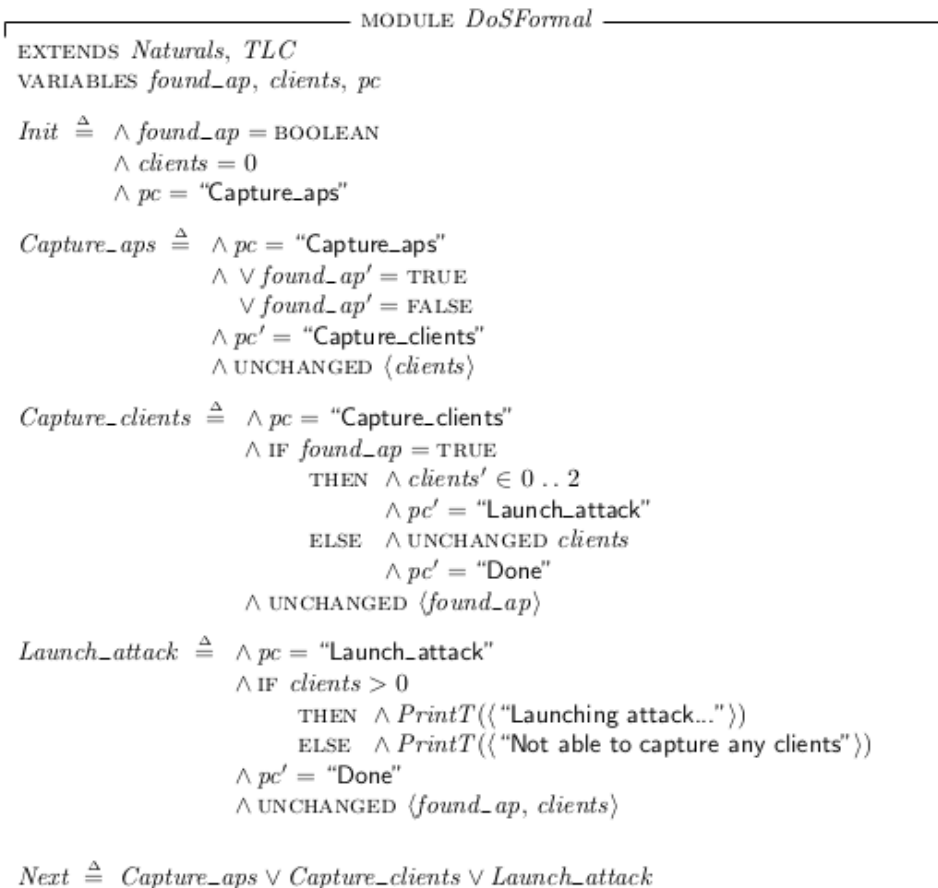
Figure 17. The formal specification of the DOS attack EP model written in